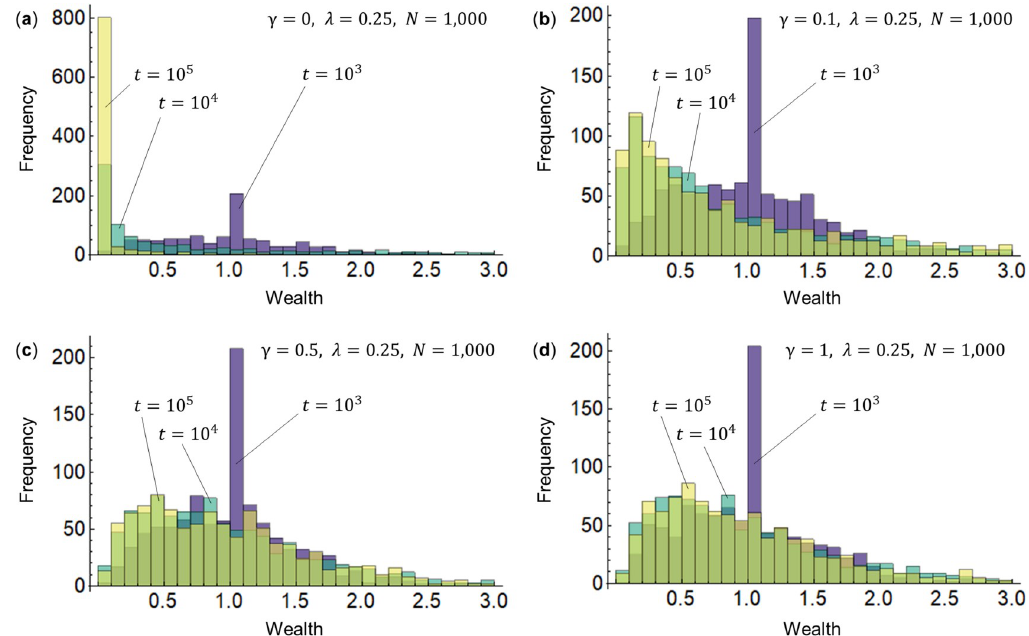
Fig 2. Wealth distribution for the surplus contribution rate γ of the wealthy. The horizontal axis represents wealth (assets) while the vertical axis represents frequency. The number of agents is set at N = 1,000. The initial value for assets at time t = 0 for all agents is m i (0) = 1( i = 1,2, ��� , N ). The saving rate for all agents is λ = 0.4. The four different surplus contribution rates of the wealthy are γ = 0, 0.1, 0.5, 1. For each case, we observe the changes in the distribution of wealth when the time (the number of changes) is t = 10 3 , 10 4 , and 10 5 .